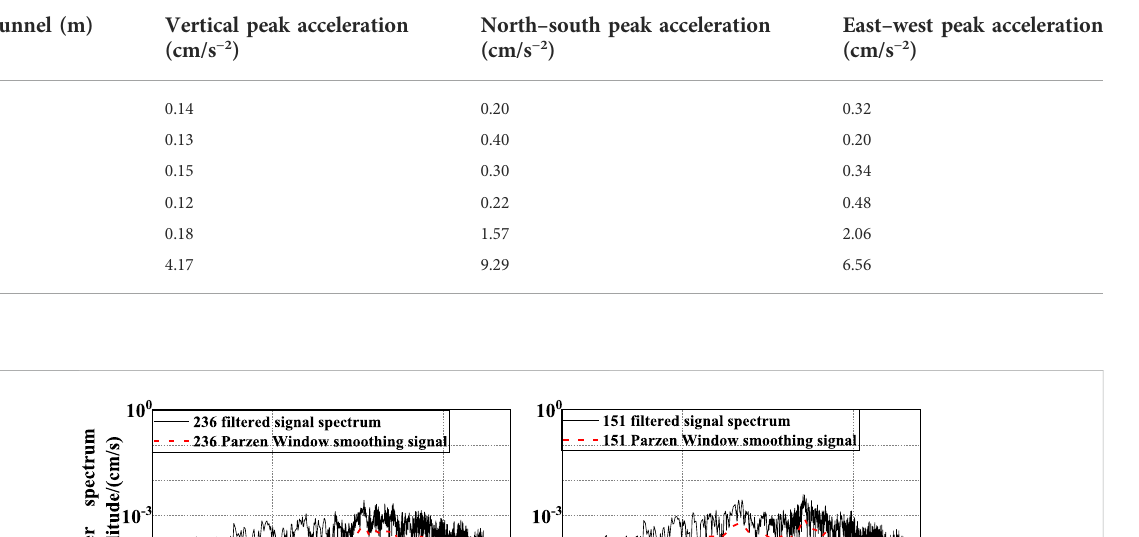
TABLE 3 Peak acceleration in n relation to depth of tunnel.